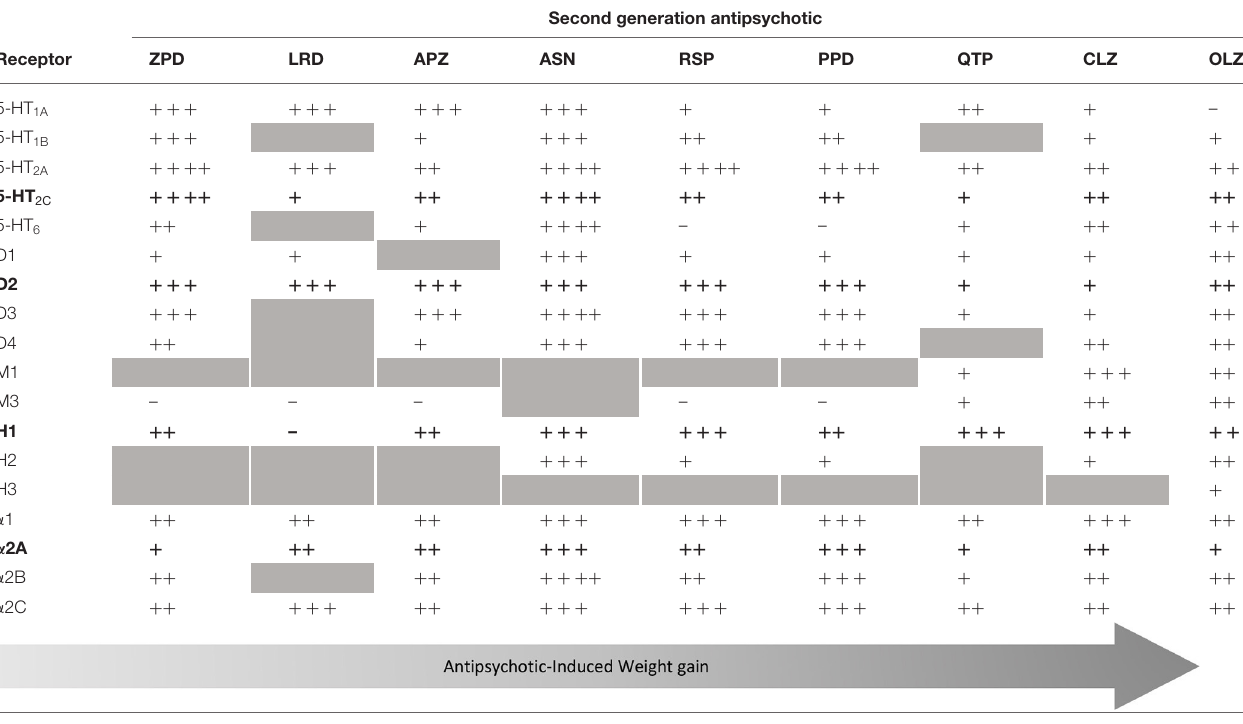
table does not provide an exhaustive receptor profile but focusses on receptors hypothesized to relate to metabolic effects. Those with the most evidence are bolded. ZPD, ziprasidone; LRD, lurasidone; APZ, aripiprazole; ASN, asenapine; RSP, risperidone; PDD, paliperidone; QTP, quetiapine; CLZ, clozapine; OLZ, olanzapine. nucleus within the hypothalamus inhibiting the expression of neuropeptide Y (NPY) and agouti-related peptide (AgRP) and stimulating proopiomelanocortin (POMC) (135–137).